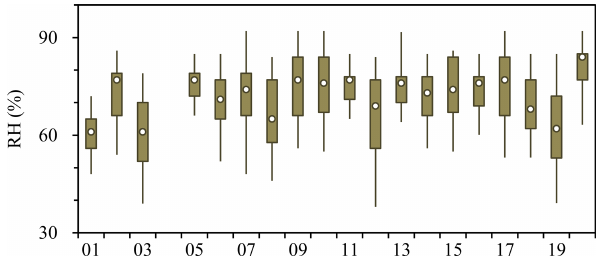
Figure 9. Comparison of RH measured during January in Harbin across the past 20 years (from 2001 through 2020). Time resolu- tion is 1h for the RH data. No observational result is available for January of